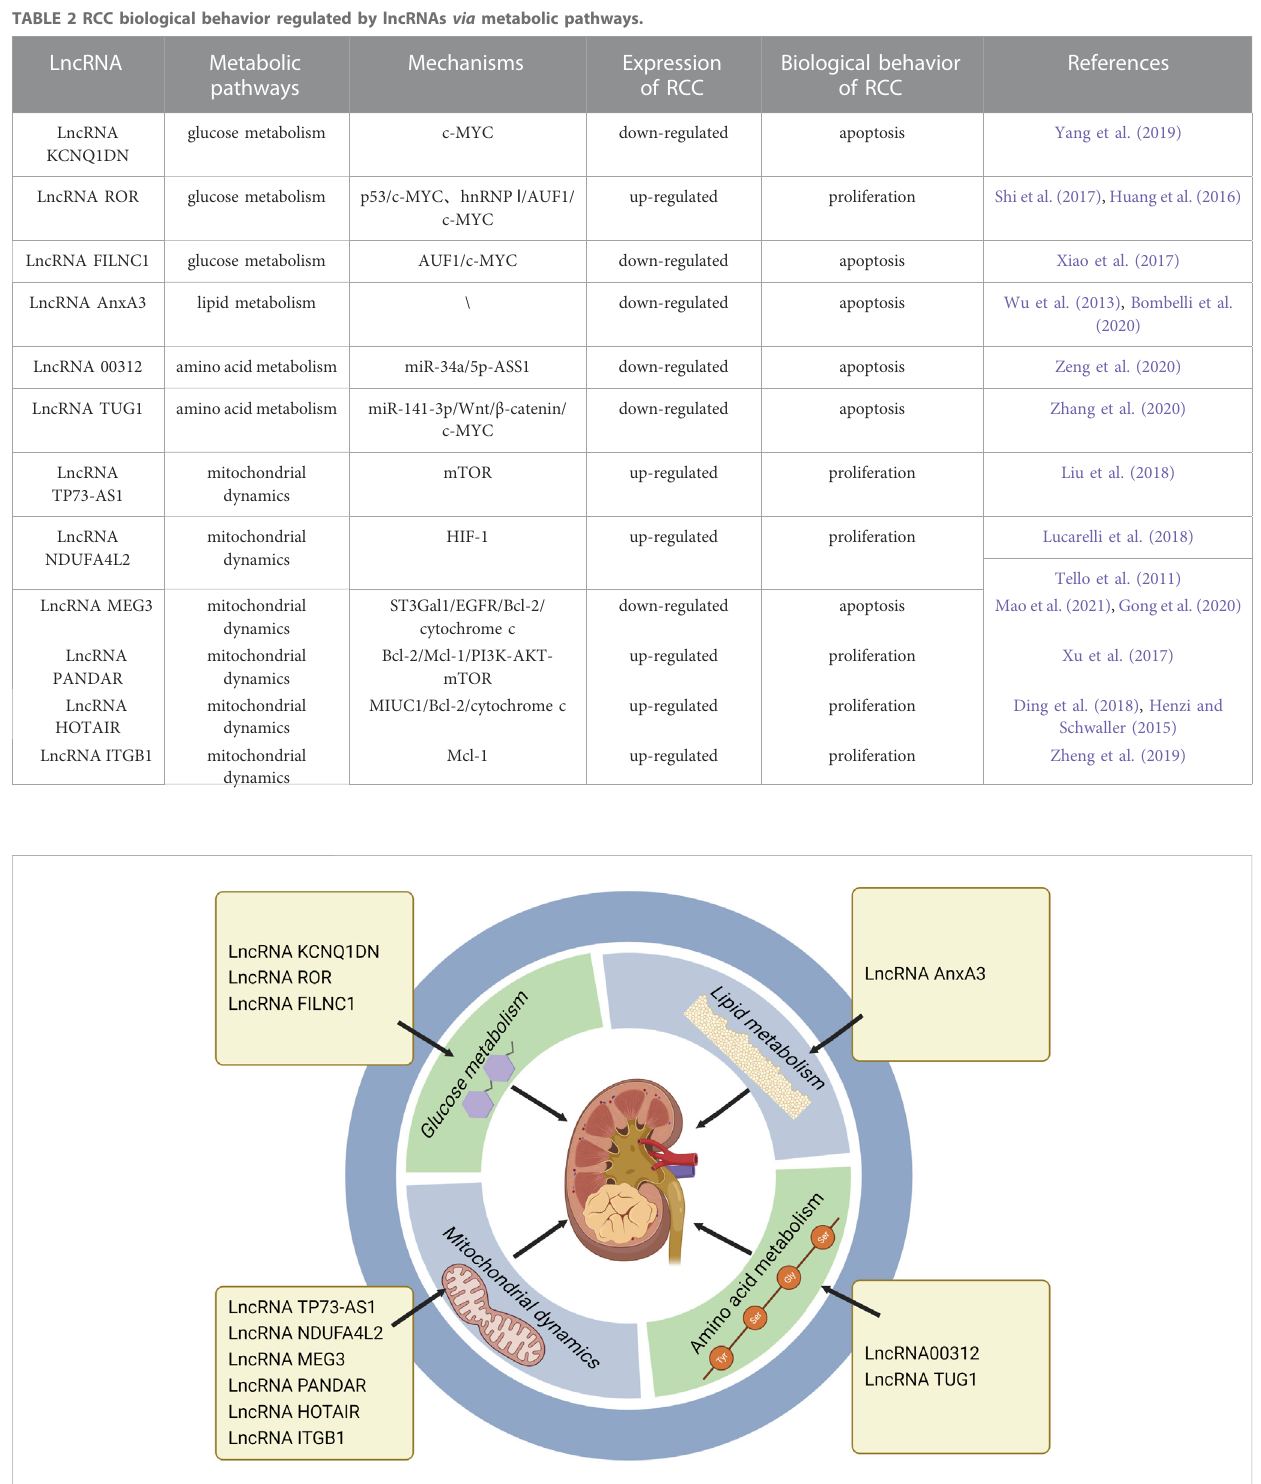
FIGURE 3 LncRNAs regulate RCC progression through metabolic pathways, especially the roles in glucose metabolism, lipid metabolism, amino acid metabolism and mitochondrial dynamics. LncRNA KCNQ1DN, ROR and FILNC1 affect RCC development via regulating glucose metabolism. LncRNA AnxA3 regulates RCC progression through lipid metabolism. LncRNA 00312 and LncRNA TUG1 exert the regulatory roles in RCC through amino acid metabolism. LncRNA TP73-AS1, NDUFA4L2, MEG3, PANDAR, HOTAIR, and ITGB1 in fl uence mitochondrial dynamics and further modulate RCC progression (Created with